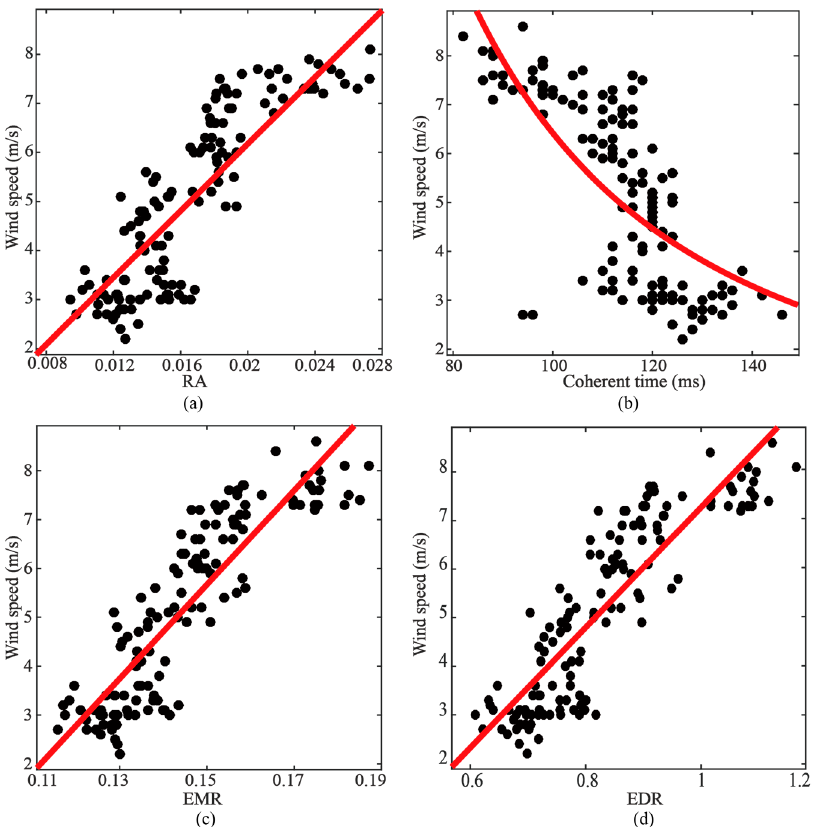
2 0.3 Threshold = . The